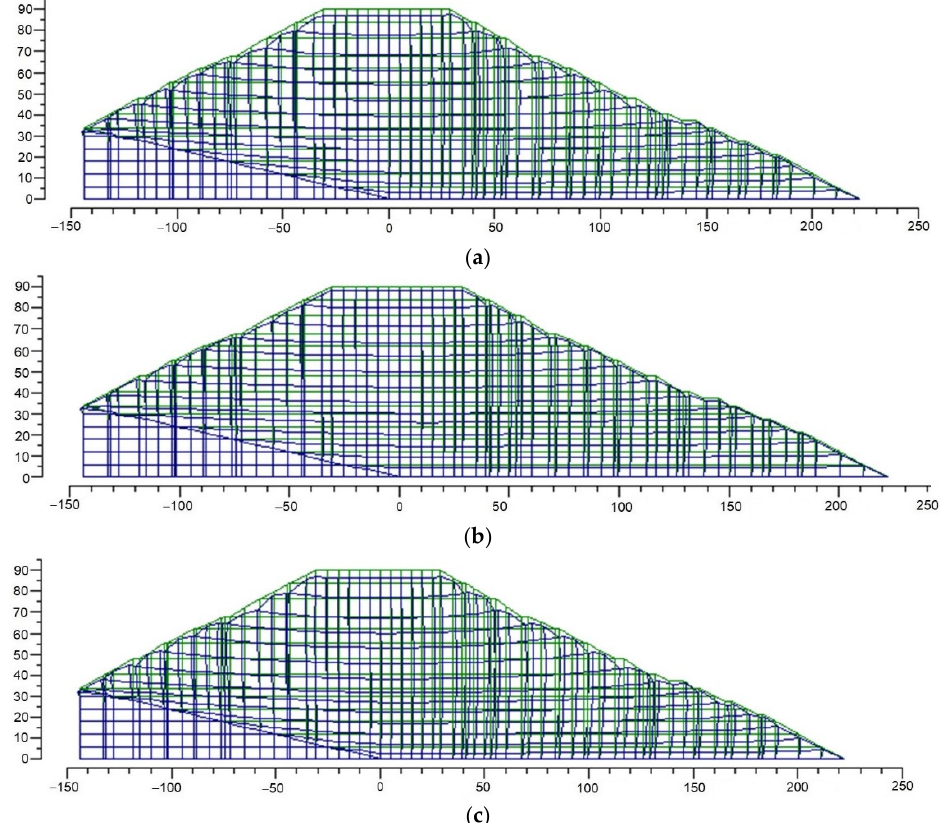
Figure 12. Deformation of embankment for gravel content ( P ) = 50 (displacements scaled up 25 times): ( a ) analysis results using material constants obtained from one-dimensional compression test (experimental result); ( b ) analysis results using material constants corrected using the Walker–Holtz method (Walker–Holtz method); ( c ) analysis results using material constants corrected with the formula proposed in this study (new